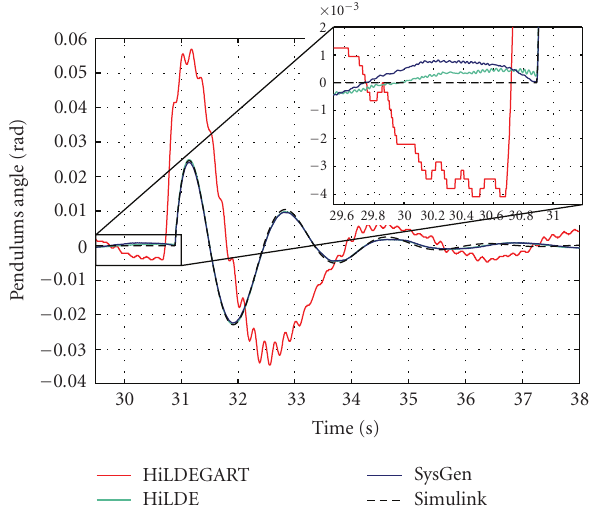
Figure 6: Inverted pendulum controller: angle of the